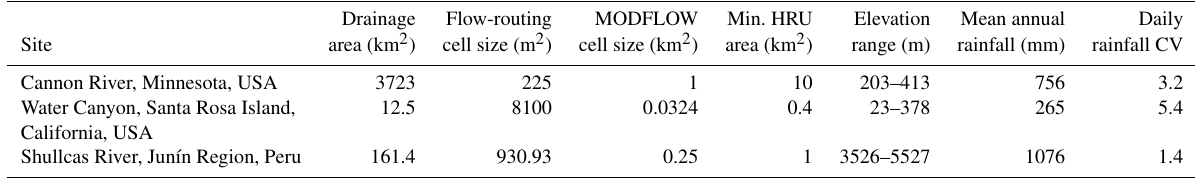
Figure 6. Model based on Cannon River, Minnesota, USA. (a) Map with MODFLOW grid, HRU outlines, stream segments (blue), and digital elevation model. (b) Simulated discharge after an 11cm rainfall event. (c, d) Relatively low-gradient hydraulic head distributions in two MODFLOW layers representing an upper glacial till unit (low hydraulic conductivity) and lower fractured carbonate bedrock (higher hydraulic conductivity), with elevation contours (ma.s.l.). (e) A 3-year hydrograph showing uncalibrated discharge simulations matching observations reasonably well during nonpeak flood times but poorly during many of the actual peaks. Table 2. Catchment and hydrological characteristics of the GSFLOW–GRASS example sites. Drainage Flow-routing MODFLOW Min. HRU Elevation Mean annual